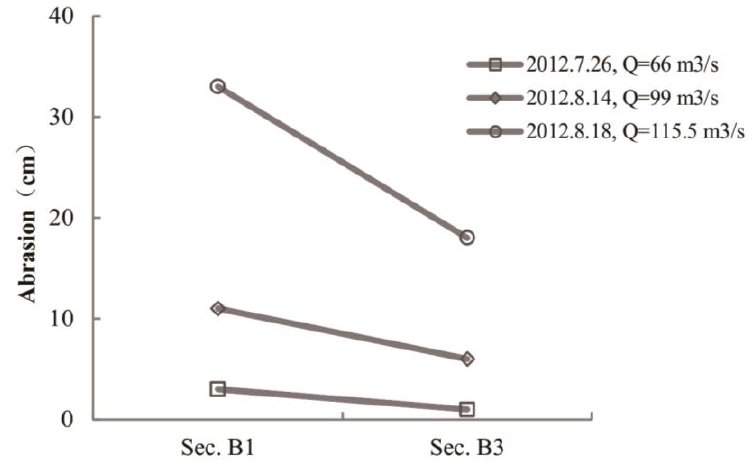
Figure 12. Development of abrasion at the bottom of the upper and lower sections of the ED section.